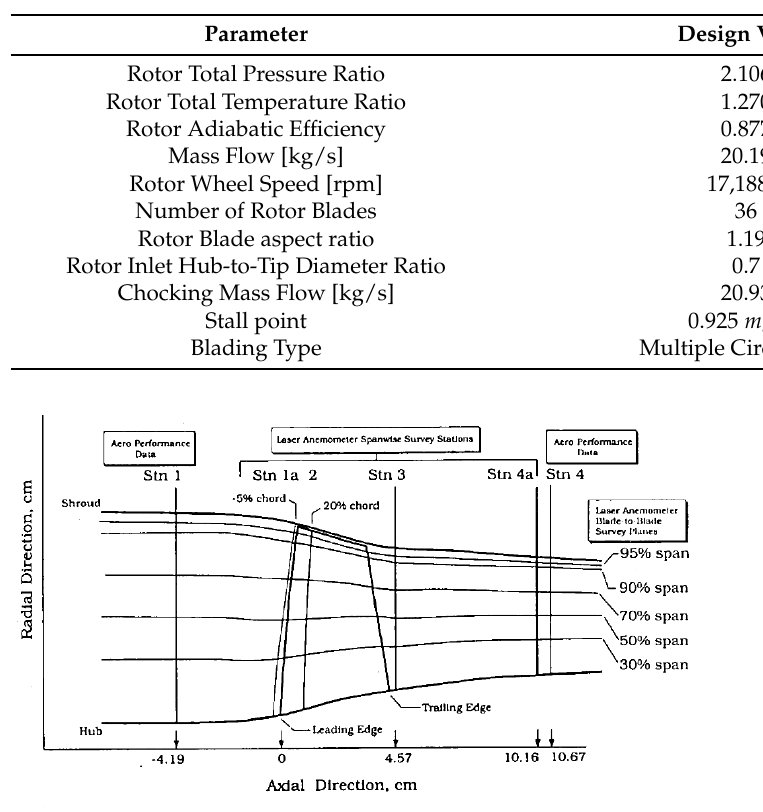
Table 3. Design specifications of NASA rotor 37 [17].